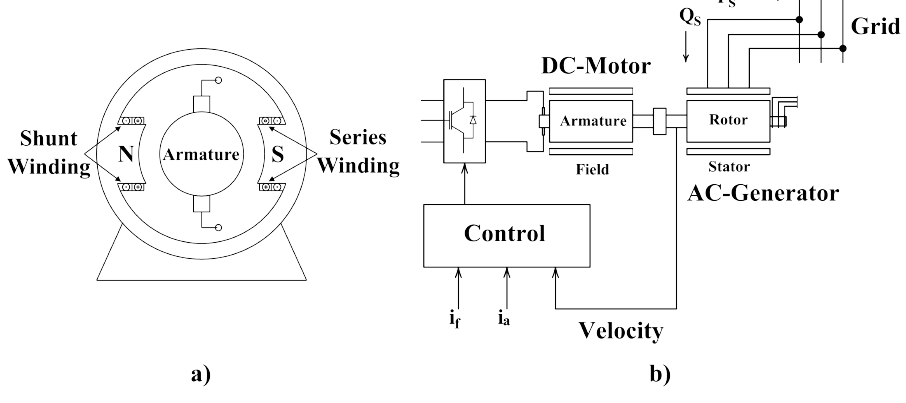
Figure 1. ( a ) DC motor scheme, and ( b ) DC motor velocity controller